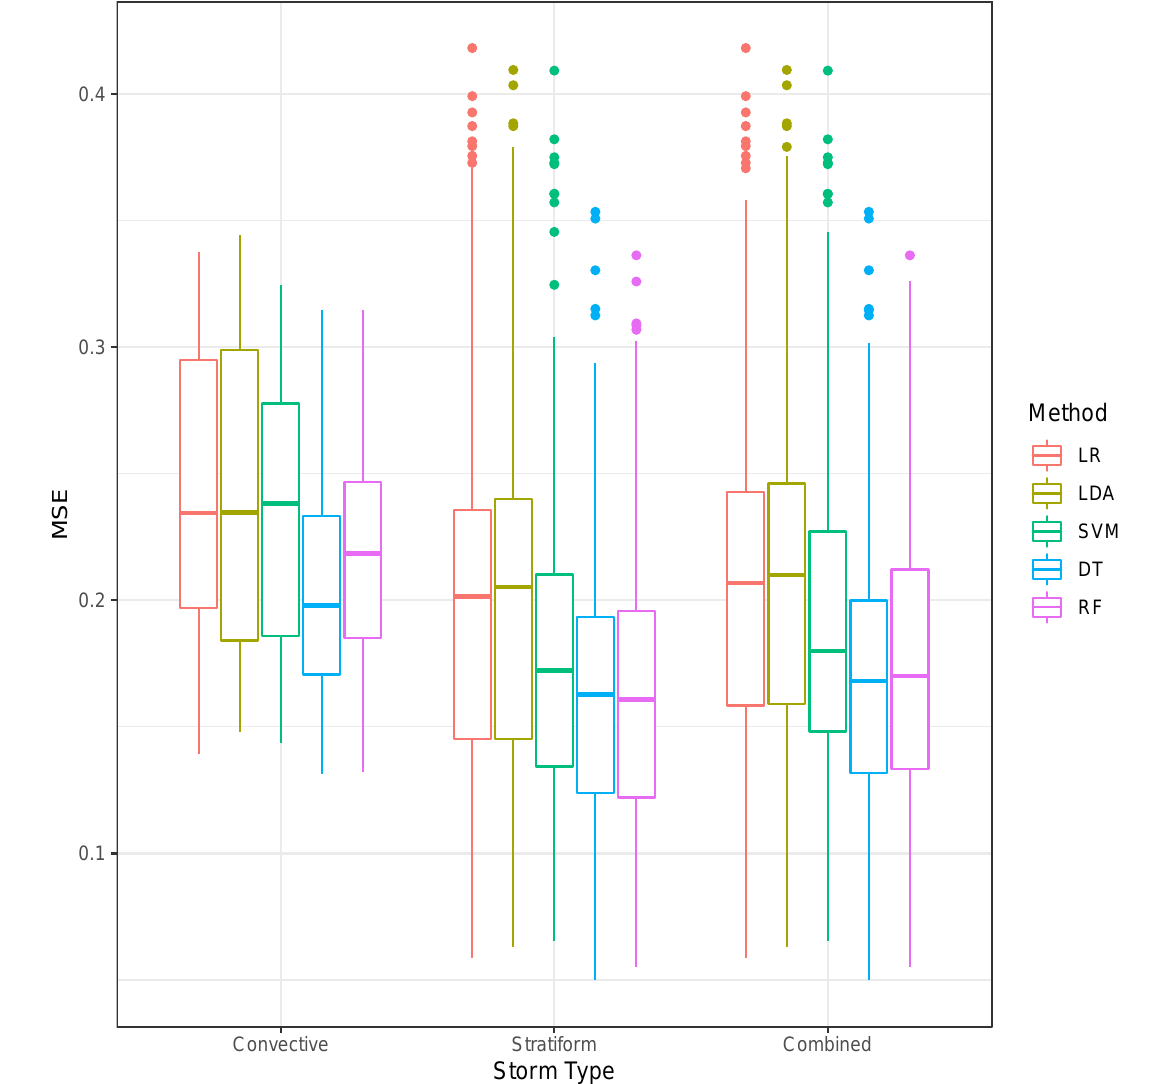
Figure 10. Boxplots of the MSPE for the three types of events by classification method.